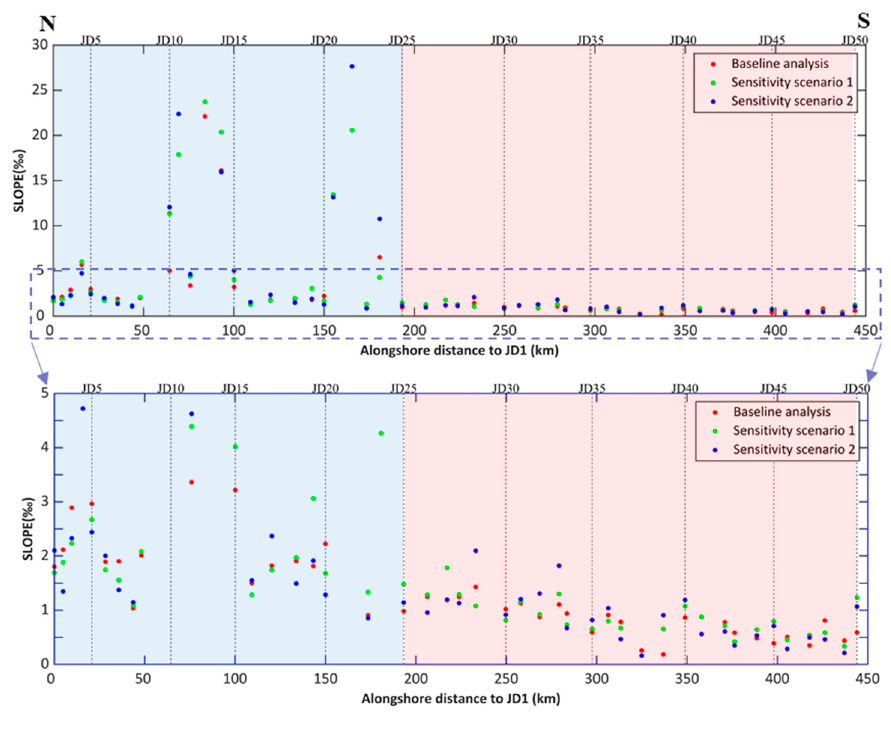
Figure 13. Intertidal beach slopes of the 50 profiles calculated with different boundaries.